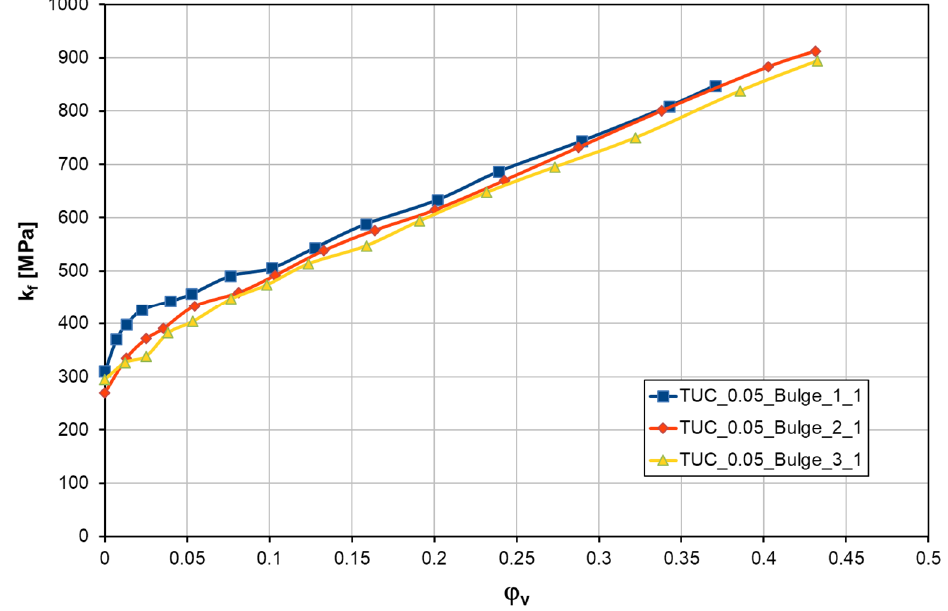
Figure 3. Calculated flow curve for 1.4404 with a thickness of 0.05 mm [Vitesco Technologies Group AG]—the colors show different repetitions.